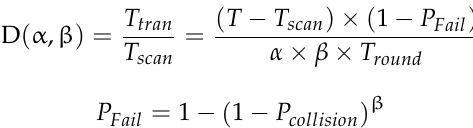
Figure 12. The influence of different scanning modes on the transmission magnification within a fixed sensing time.